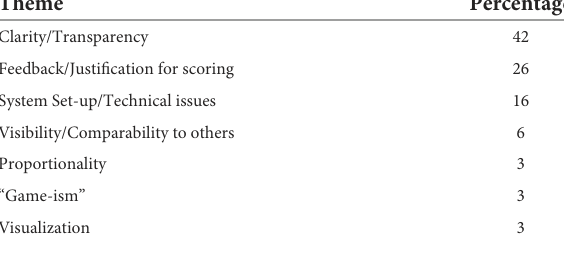
TABLE 1 Locked shields (LS) scoring feedback themes.